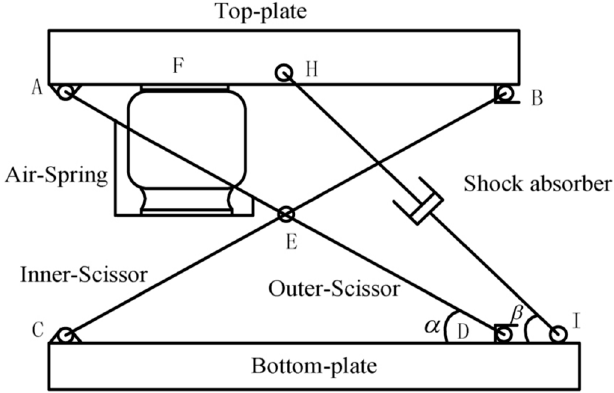
Figure 7. Scissor structure of active seating suspension system [64].